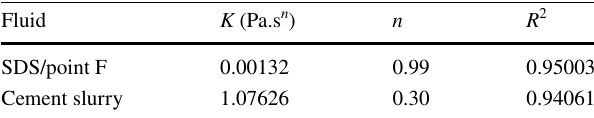
Table 6 Rheological parameters of flushing fluid (SDS/point F) and cement